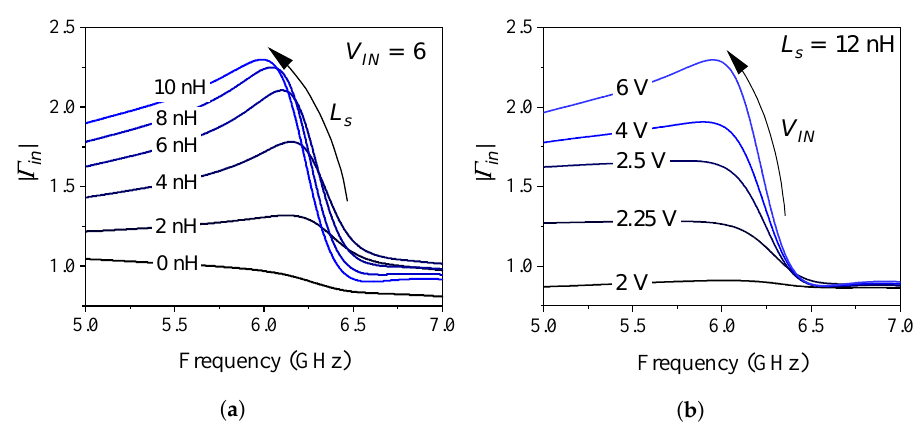
Figure 2. ( a ) Impact of inductive generation on | Γ in | . ( b ) Bias voltage on | Γ in | .